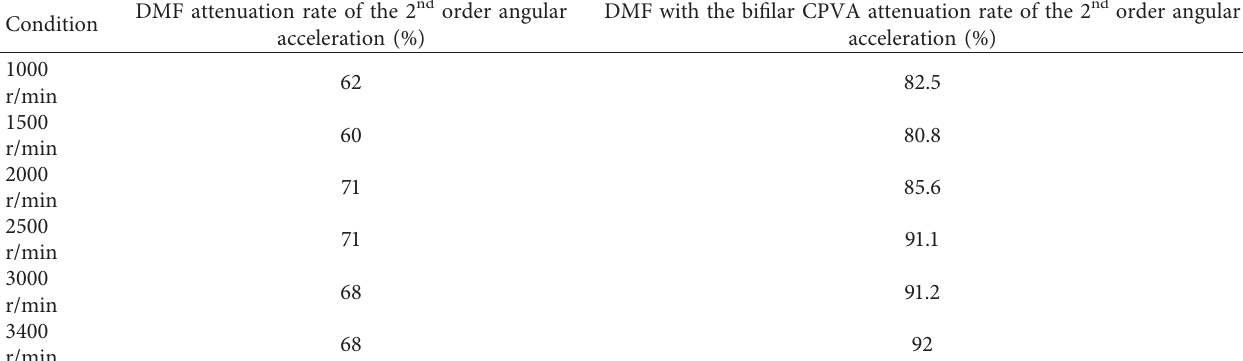
Table 11: Attenuation rate of the 2 nd order angular acceleration under the driving condition.